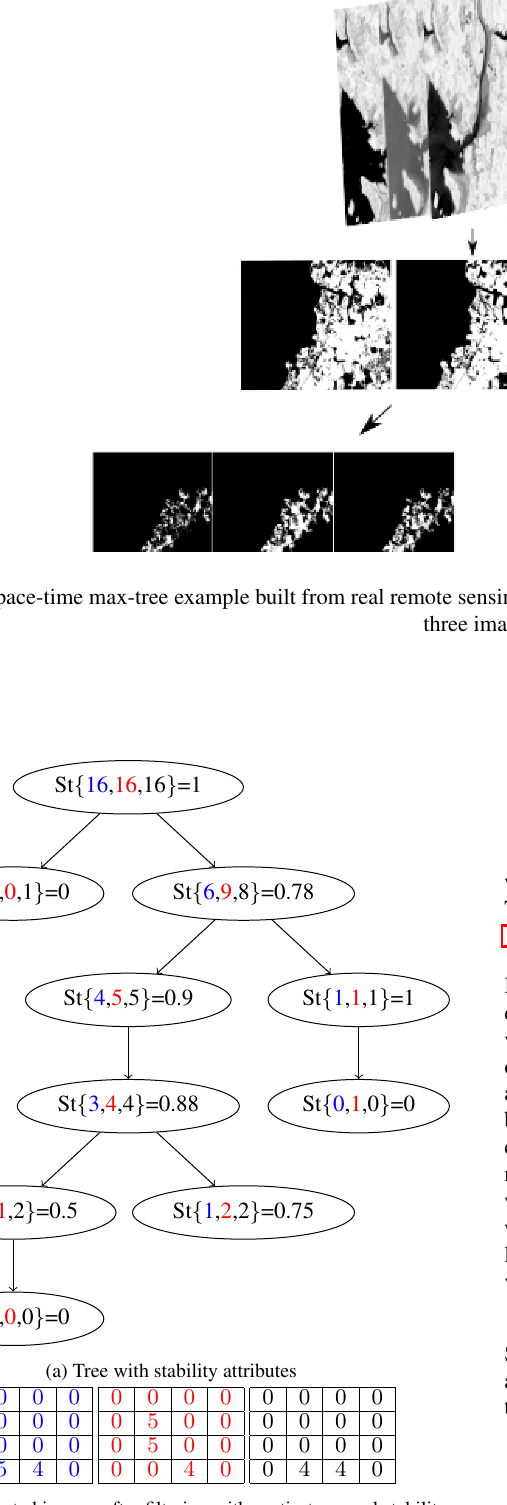
Figure 3. Illustration of the spatio-temporal stability analysis of a space-time tree.